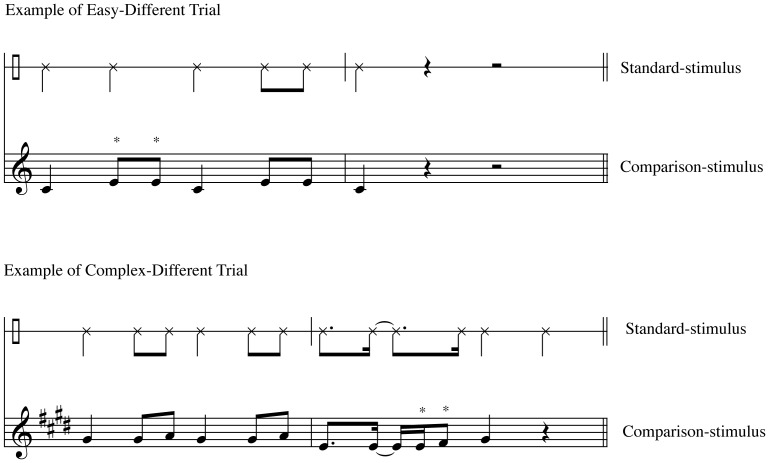
Example of rhythm-to-melody trials.An easy trial consists of a simple rhythm (mostly quarter notes and eighth notes), as compared with a complex trial, which consists of a more complicated rhythm (eighth notes and sixteenth notes). All melodies (comparison-stimuli) are tonal. *Represents the alteration in the comparison-stimuli.